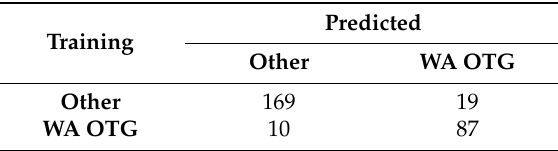
Table 6. Confusion Matrix results for baseline linear SVM classifier with 5-fold cross validation for the ADon dataset.